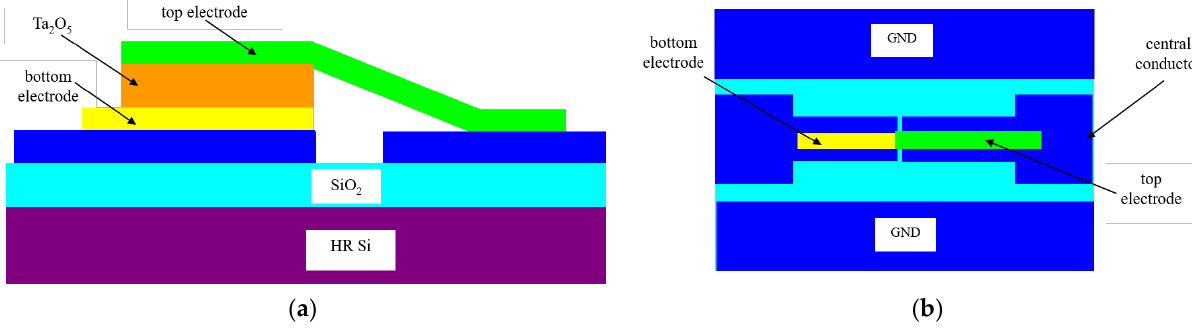
Figure 3. The microwave filament memristor in coplanar waveguide (CPW) technology: ( a ) cross-section; ( b )